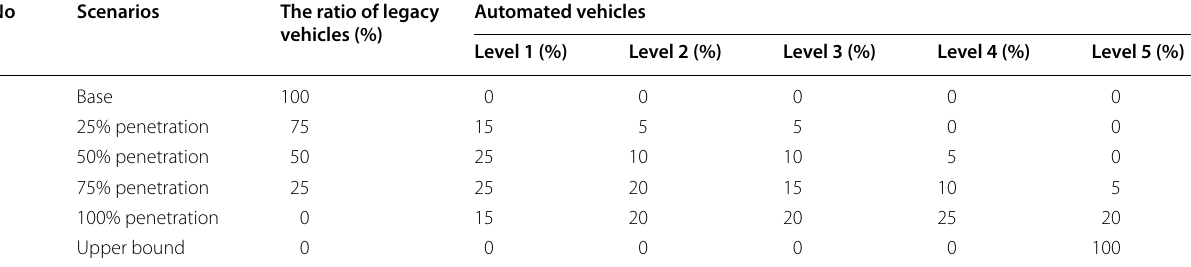
Table 2 AV market penetration rates No Scenarios The ratio of legacy vehicles